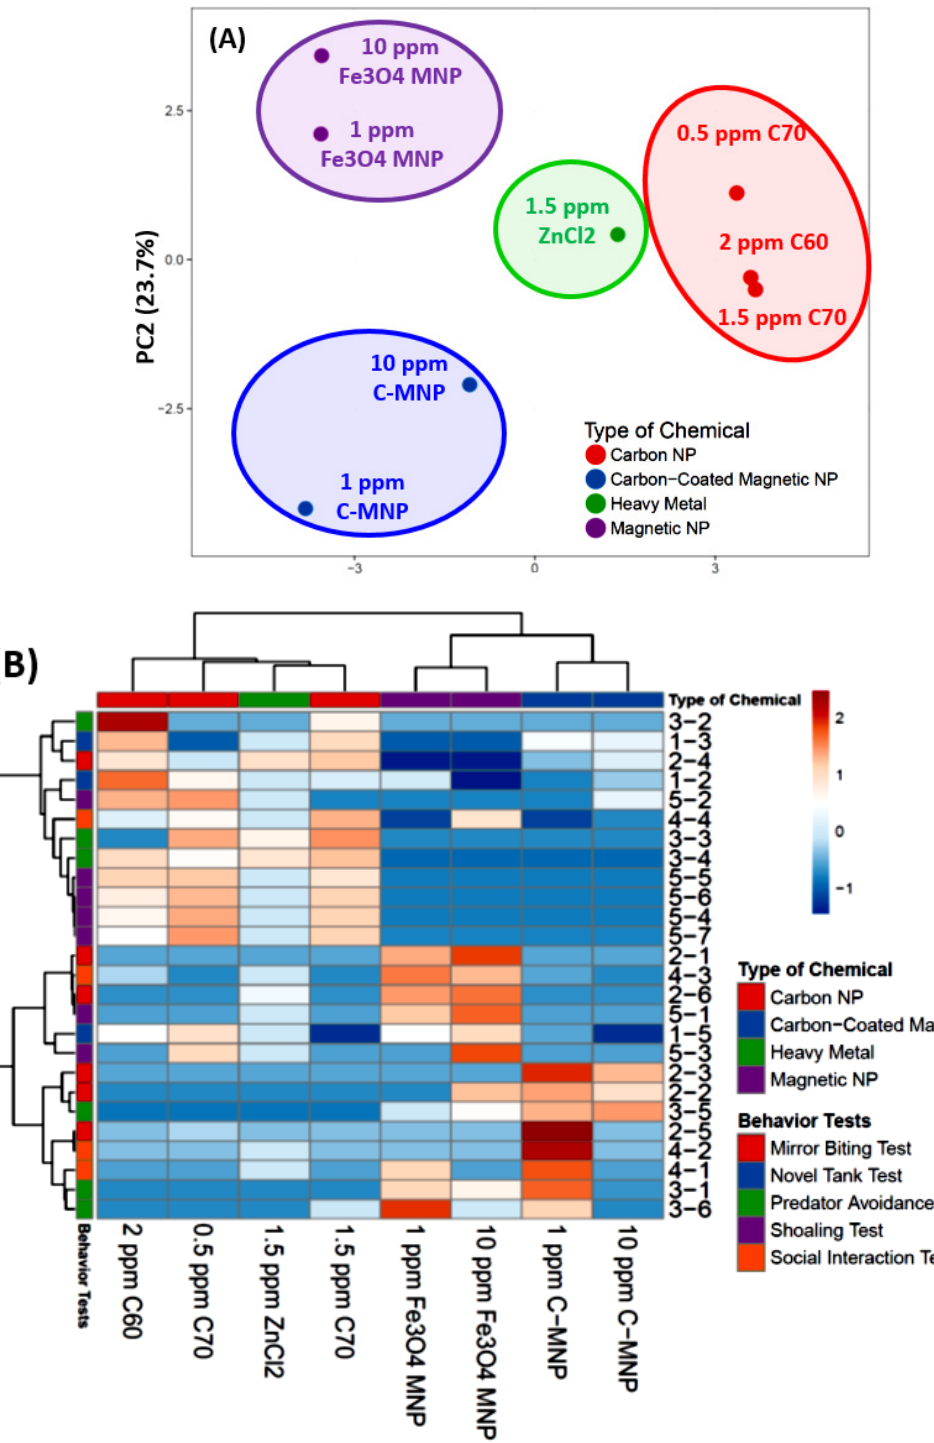
Figure 7. ( A ) Principal Component Analysis (PCA) and ( B ) hierarchical clustering analysis of multiple behavior endpoints in zebrafish after carbon-coated magnetic nanoparticles (C-MNPs) exposure (blue). In addition, the behavioral toxicity data obtained from our previous publications of ZnCl 2 (green), C60 NPs (red), C70 NPs (red), and uncoated magnetic nanoparticles (purple) chronic exposure in adult zebrafish were also included to compare the behavioral toxicity patterns of each treated group. In Figure 7A, four major groups from each type of chemical were marked with di ff erent colors of